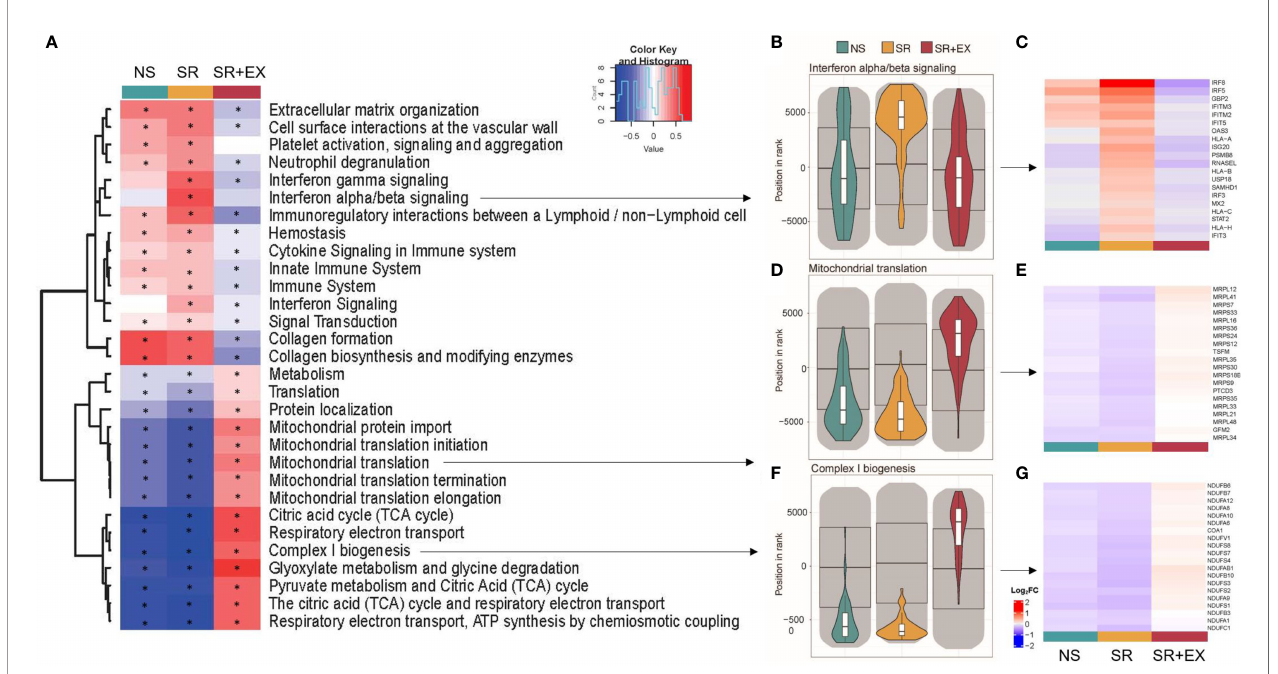
FIGURE 2 | Gene set enrichment analysis (GSEA). (A) Heat map representing the top 30 signi fi cantly altered gene sets from the ‘ REACTOME ’ gene ontology (based on MANOVA analysis using the mitch R package (46). (B, D, F) Violin plots representing the direction of expression in each group for b) Interferon alpha/beta signalling, (D) Mitochondrial translation, and (F) Complex I biogenesis. (C, E, G) heat maps for the 20 leading-edge genes for the corresponding violin plots (Log 2 FC from pre- to post-intervention). Normal Sleep (NS), Sleep Restriction (SR), and Sleep Restriction and Exercise (SR+EX). * Denotes signi fi cant within group difference from pre-intervention, adjusted P